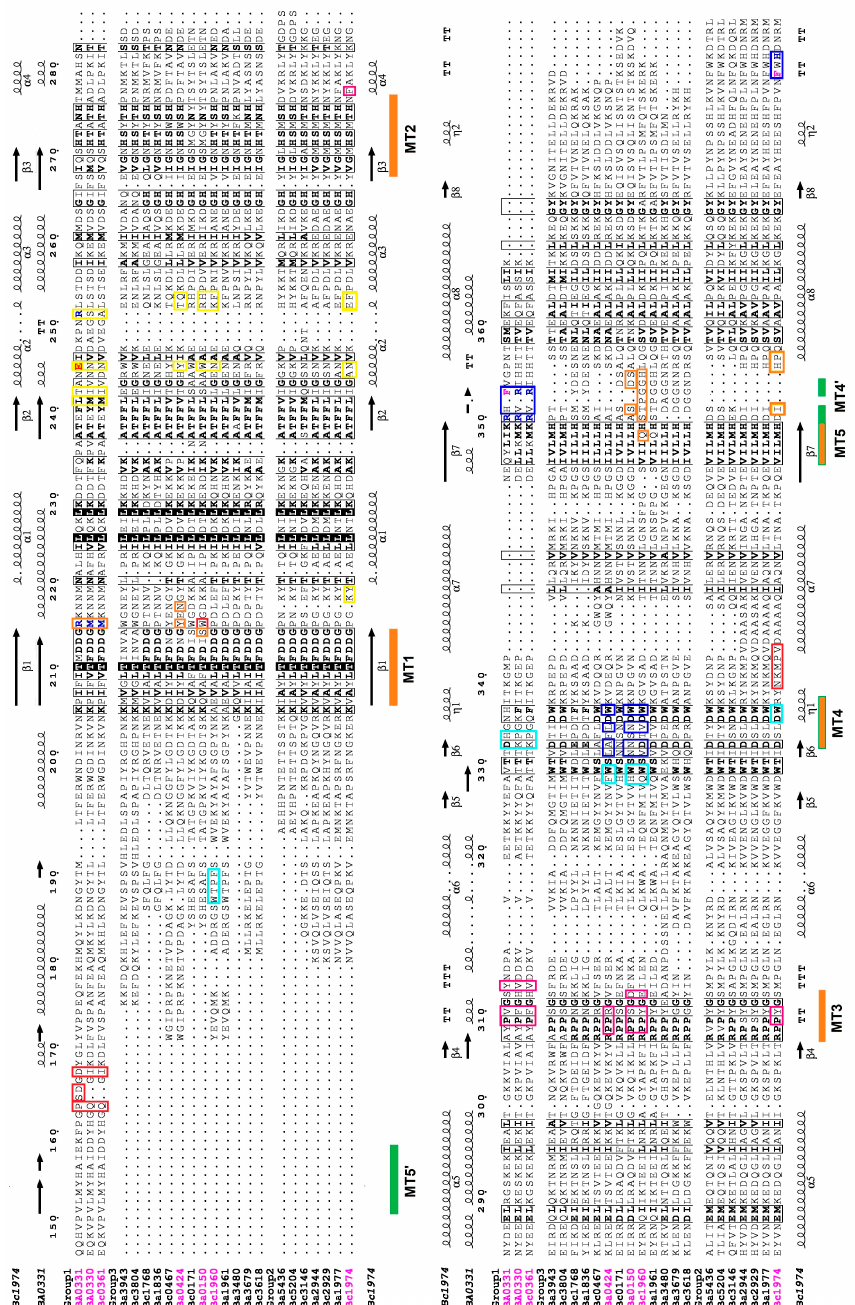
Figure 4. Sequence alignment diagram of the NodB domain of 23 B. anthracis str. Ames and B. cereus str. ATCC14579 PDAs. Numbering is according to Ba0331. Proteins with known tertiary structures have their name coloured purple. Highly conserved residues between the sequences are given in bold letters. Coloured bars show the conserved motifs. The amino acids found in the binding site-forming are boxed in blue, cyan, magenta, yellow, orange, or red colours, respectively. The secondary structure of Ba0331 and Bc1974 is shown on the top and bottom ( α -helices as spirals, β -strands as bold arrows, turns as bold T). Diagram using the program ESPRIPT [60].